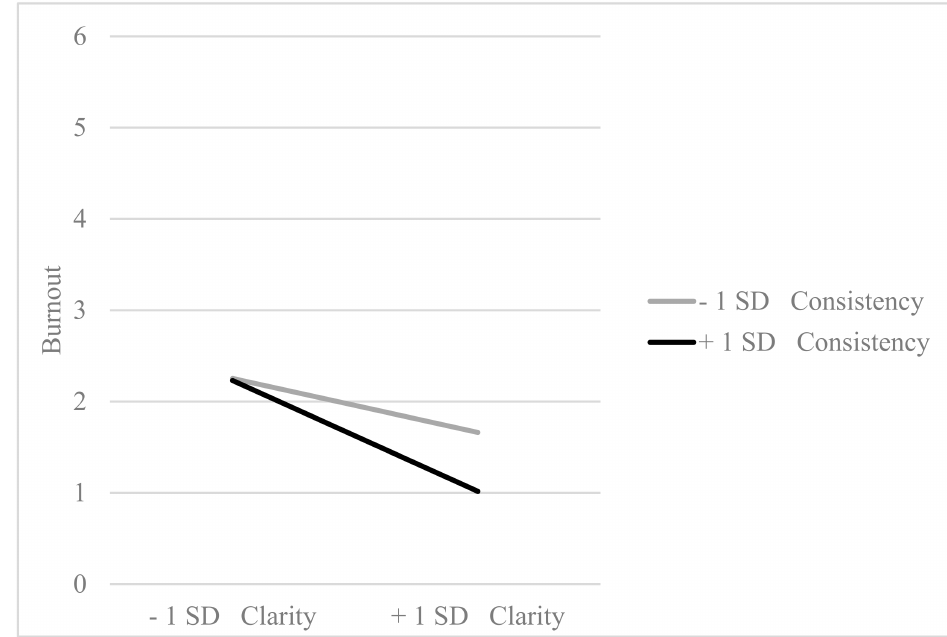
Figure 1. Interaction effect between clarity and consistency in the office employees’ sample ( β = − 0.16, p = 0.005). Additionally, consequences modulated the effect of constraints on burnout ( β = − 0.11, p = 0.030), in such a way that the positive effect of high constrains on burnout is signifi- cantly attenuated when the consequences are high (Figure 2). This interaction explained a significant amount of variance of burnout ( ∆ R 2 = 0.06, p = 0.021). In the sample of teachers, consequences modulated the effect of constraints on burnout ( β = − 0.14, p = 0.011), pro- ducing the same effect that was explained for the sample of office workers (see Figure 3). This interaction explains a significant 5% of the burnout variance in teachers.